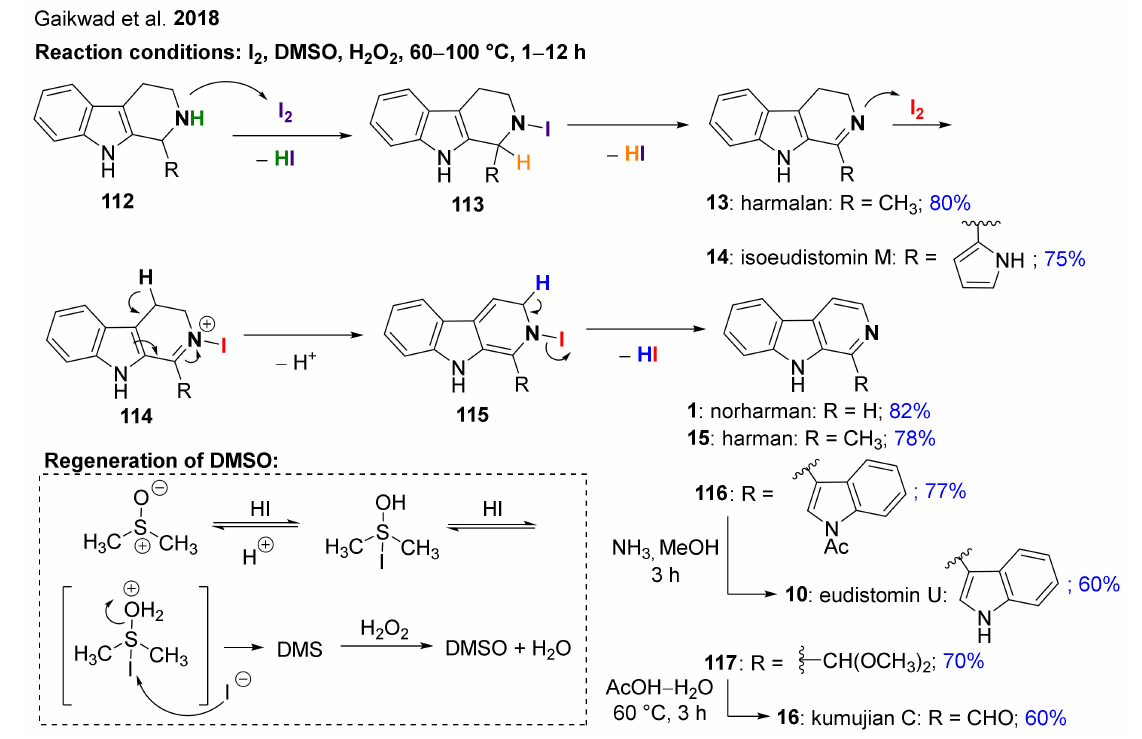
Scheme 9. Synthesis of harmalan ( 13 ), isoeudistomin M ( 14 ), norharman ( 1 ), harman ( 15 ), eudistomin U ( 10 ) and kumujian C ( 16 ) via iodine-mediated